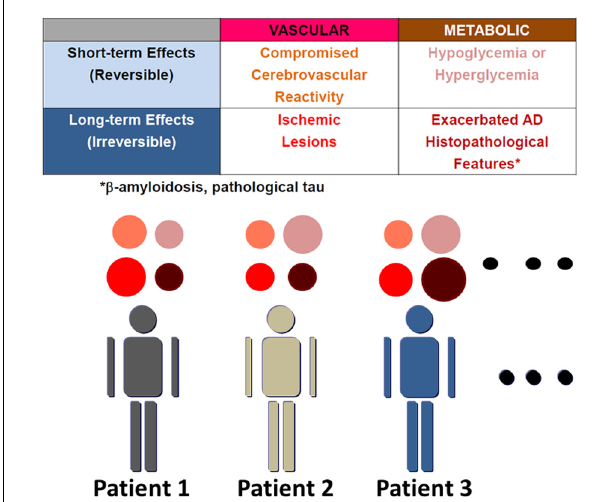
FIGURE 1 |Variable mechanisms by whichAD patients with non- genetic risk factors manifest cognitive dysfunction. The mechanisms whereby non-genetic risk factors modify cognitive dysfunction are divided into four elements: short- and long-term effects of vascular and metabolic factors.These are (1) compromised vascular reactivity, (2) vascular lesions, (3) hypo/hyperglycemia, and (4) exacerbated AD histopathological features, respectively. AD histopathological features include β -amyloidosis and pathological tau. β -amyloid also compromises vascular reactivity and causes microhemorrhages due to cerebral amyloid angiopathy.The contribution of these four elements to manifestation of cognitive dysfunction varies among patients, though all components must not always be